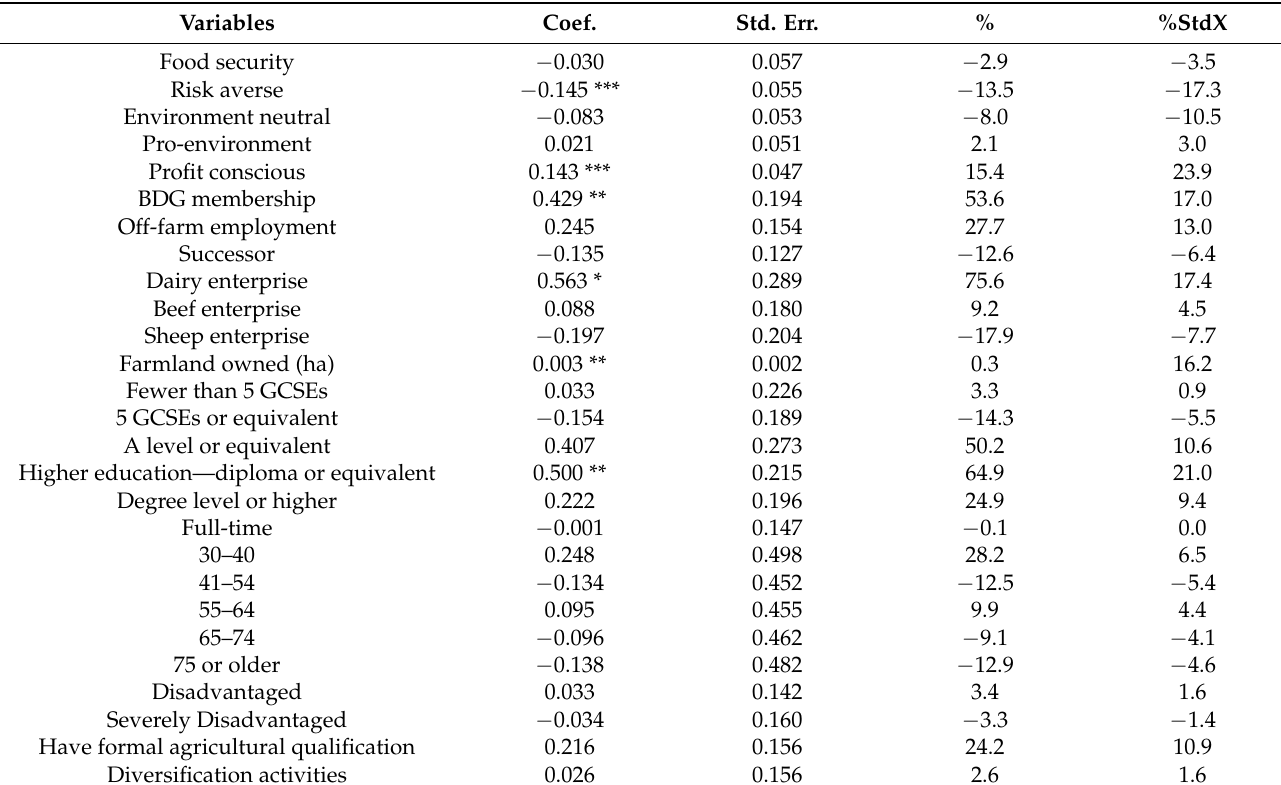
Table 4. Estimates of determinants of intention to adopt long-term land leasing with tax incentives (N =